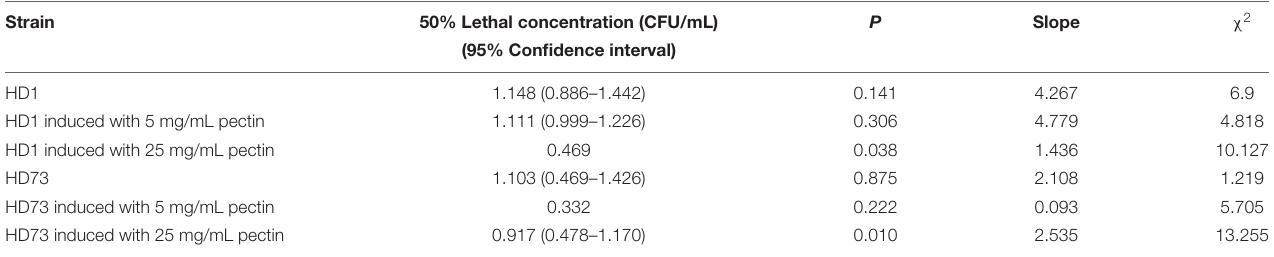
TABLE 2 | Dose–response insecticidal activities of the spore–ICPs of HD1 and HD73 strains. Strain